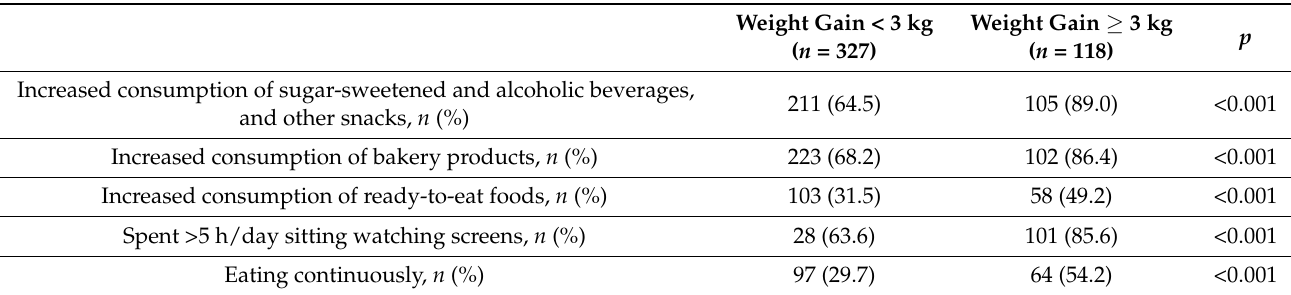
Table 3. Cont. Table 3. Significant differences in respondents who self-reported weight gain according to the amount of weight gained.